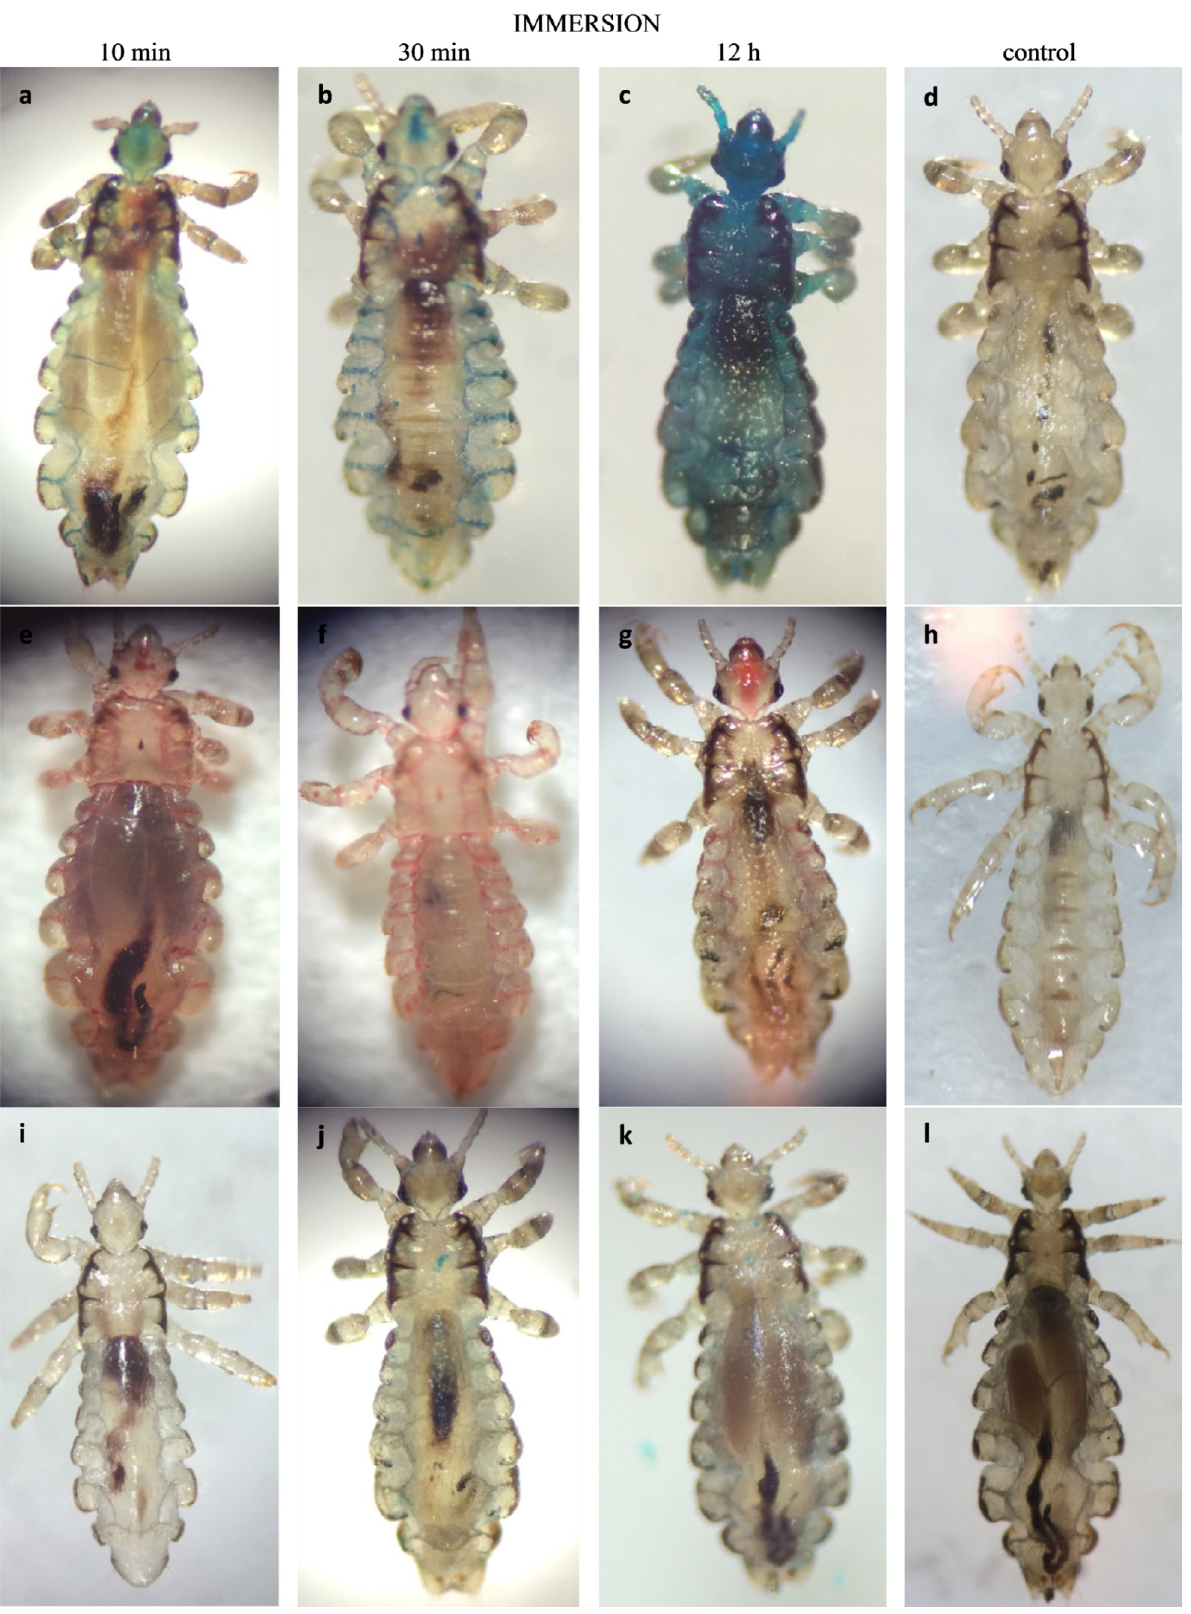
Figure 4. Photographs of head lice immersed in ethanol ( fi rst row), in dimeticone/cyclomethicone (second row) or in water (third row). Dark-blue stained ethanol entered across spiracles and fi lled the respiratory system (a, b,c), control (d). Red-stained dimeticone/ cyclomethicone entered across spiracles and fi lled the respiratory system (e, f, g), control (h). Dark blue stained water did not penetrate the respiratory system (i, j, k), control